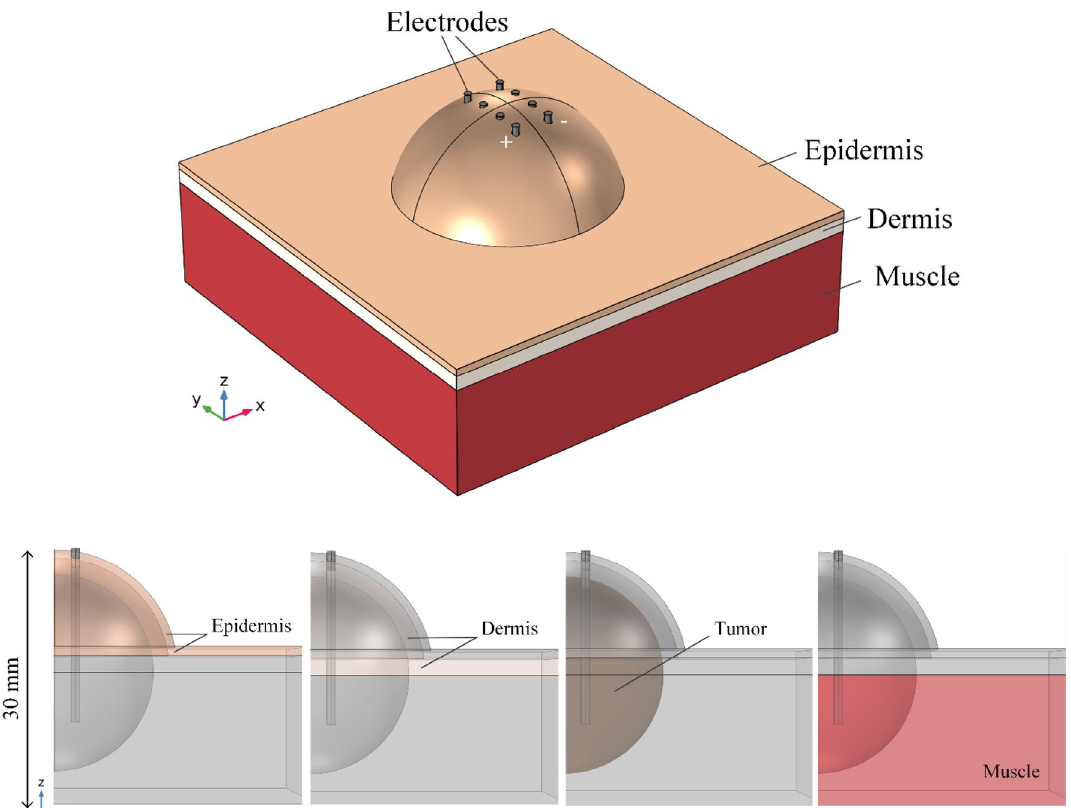
Figure 6. Numerical geometry of the tumor case study with ESOPE Type II electrode in its standard configuration. The case consists of a subcutaneous tumor. The tumor mass growth forces the upper tissues to spherically reshape. All geometry planes were generated by COMSOL Multiphysics v.5.1 (COMSOL Inc., Stockholm, Sweden; https:// www. comsol. com/ comsol- multi physi